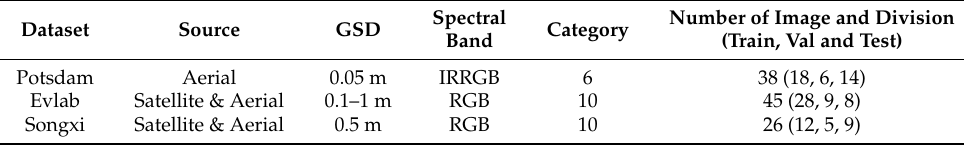
Table 2. General information of experiment